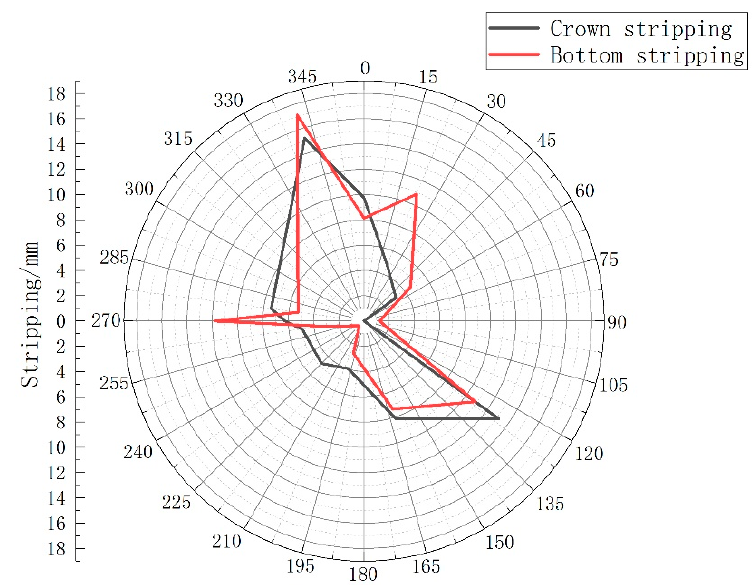
Figure 16. Stripping values of each point at the crown and bottom of the segment. Figure 16. S tripping values of each point at the crown and bottom of the segment.